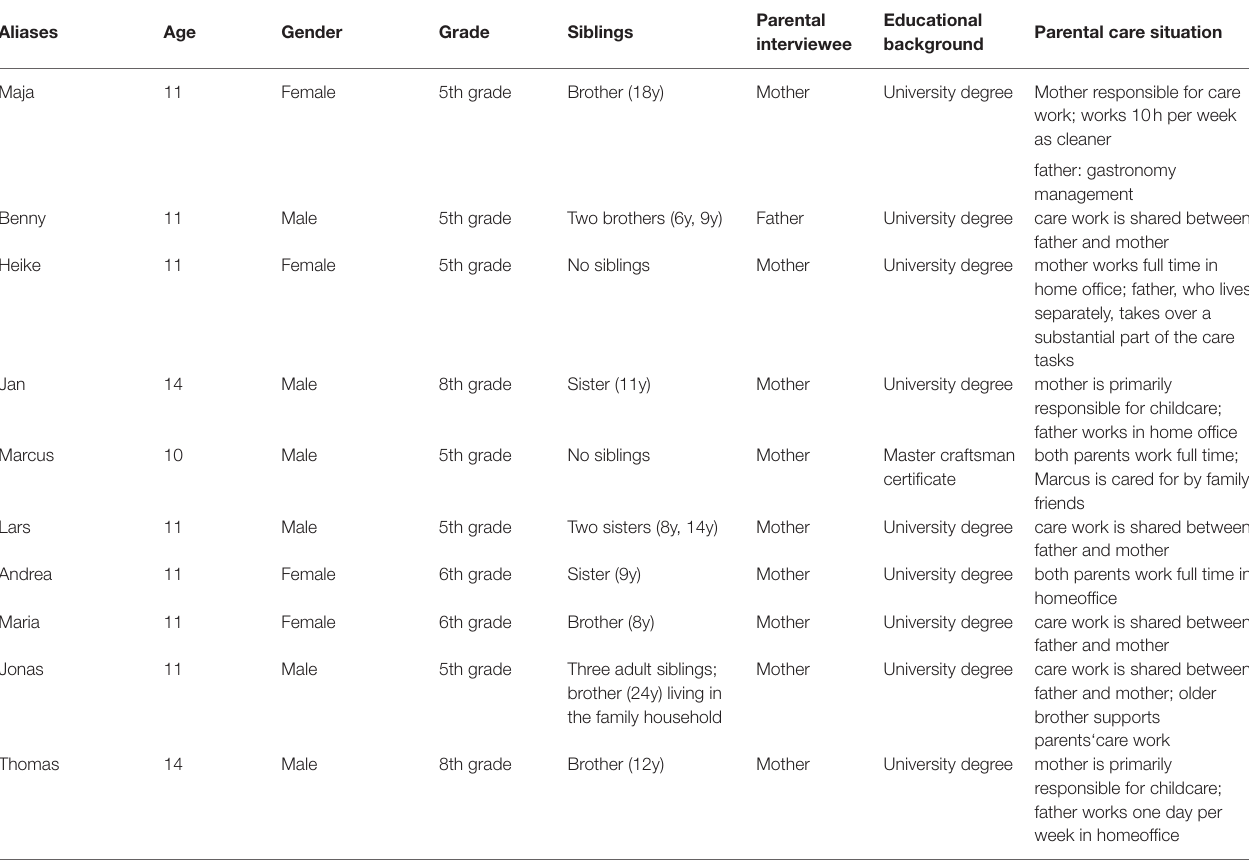
TABLE 4 | Composition of the qualitative sample. Aliases Age